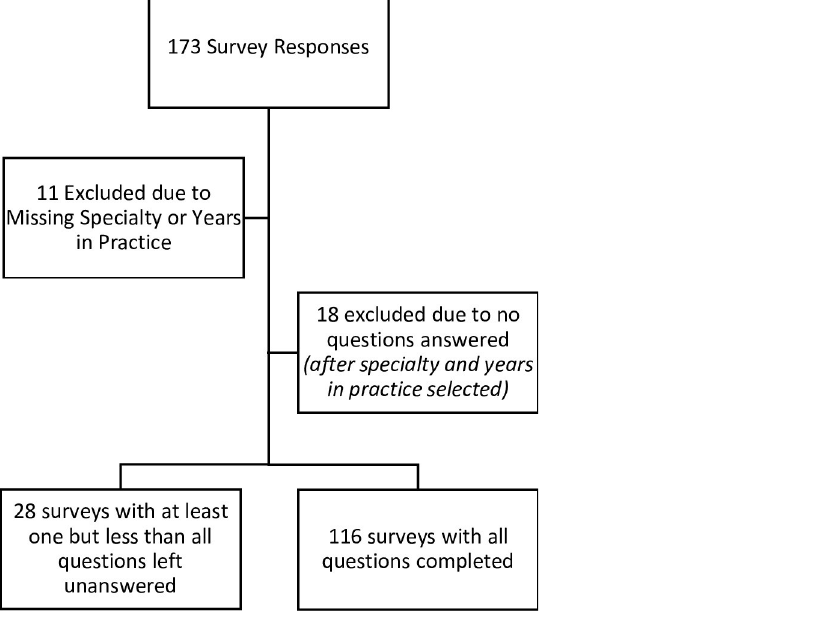
Fig 1. Included and excluded survey